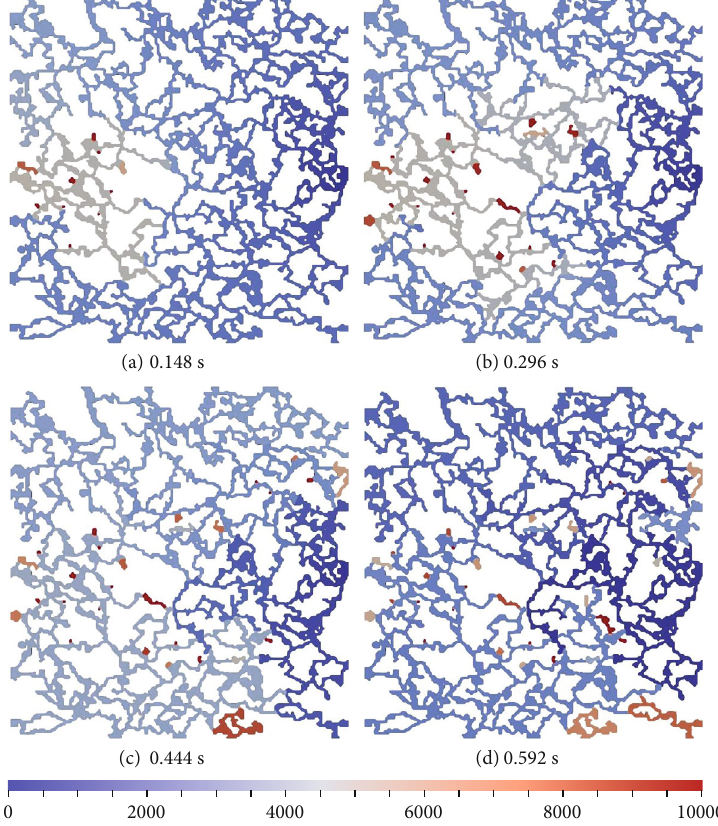
Figure 5: Pressure distribution versus